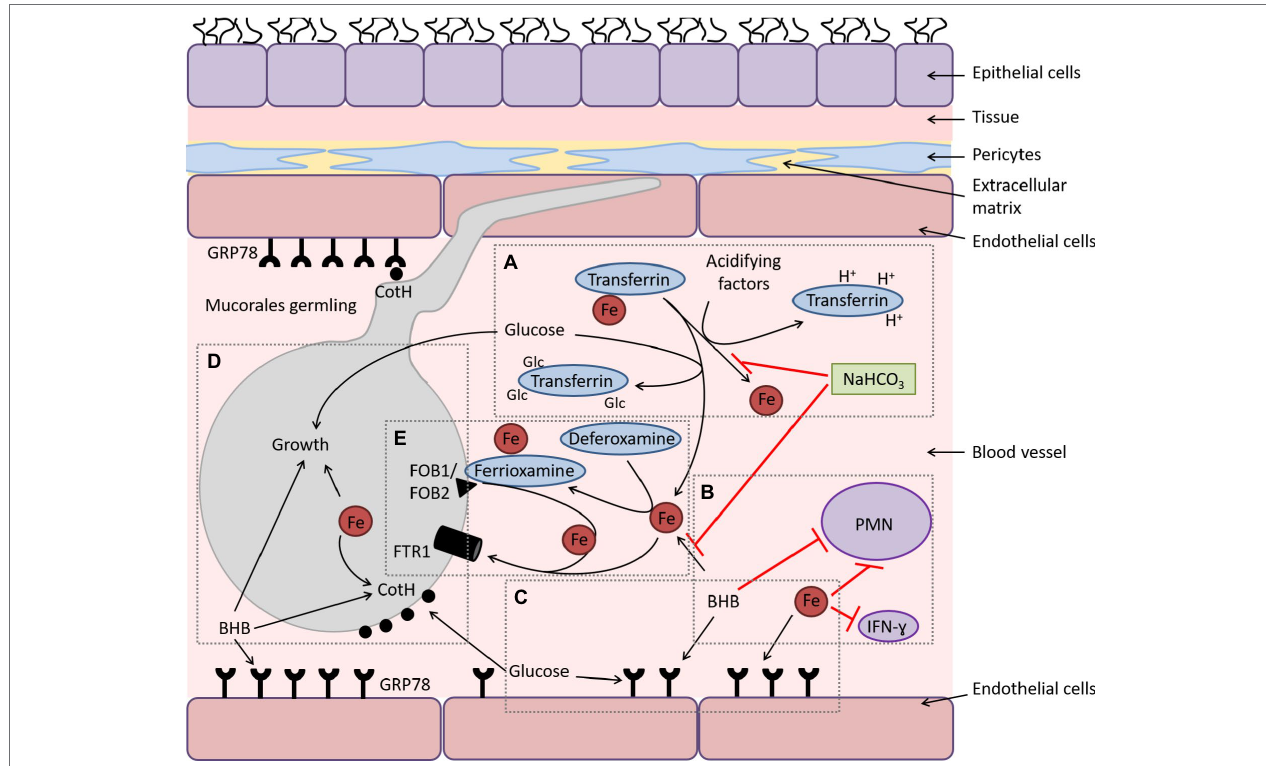
FIGURE 3 | Mucorales interaction with endothelial cells during hematogenous dissemination/organ seeding and the effect of host factors on these interactions and on the immune response. (A) Hyperglycemia and ketoacidosis result in liberation of iron from serum-sequestering proteins (e.g., transferrin) via glycosylation and protonation, respectively. (B) Ketone bodies (e.g., BHB) and free iron negatively affect the immune response to the infection, and sodium bicarbonate (NaHCO 3 ) reverses this negative effect by preventing iron release from transferrin and neutralizing acidity. (C) Surface expression of glucose-regulator protein 78 (GRP78) on endothelial cells is enhanced to cope with the stress elicited by hyperglycemia, free iron, and ketone bodies. (D) Glucose, free iron (transported by the high-affinity iron permease [Ftr1p]), and BHB also enhance the expression of the fungal cell surface CotH, which results in invasion of the endothelium and augmentation of fungal growth. (E) In deferoxamine-treated hosts, the iron-rich ferrioxamine binds to its fungal receptor (ferrioxamine binding proteins [Fob1/Fob2]) then releases iron via a reductive step prior to feeding invading Mucorales via Ftr1p transportation. (Adapted from Ref (Baldin and Ibrahim, 2017) under the terms of the Creative Commons Attribution License